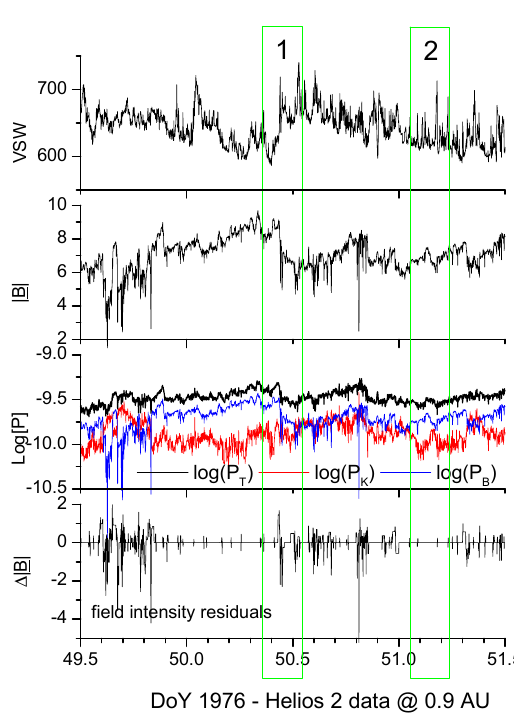
Figure 96: From top to bottom: 81 s averages of velocity wind profile in km s –1 , magnetic field intensity in nT, the logarithmic value of magnetic (blue line), thermal (red line), and total pressure (black line) in dyne/cm 2 and field intensity residuals in nT. The two vertical boxes delimit the two time intervals #1 and #2 which were chosen for comparison. While the first interval shows strong magnetic intermittency, the second one does not. Image reproduced by permission from Bruno et al. (2001), copyright by